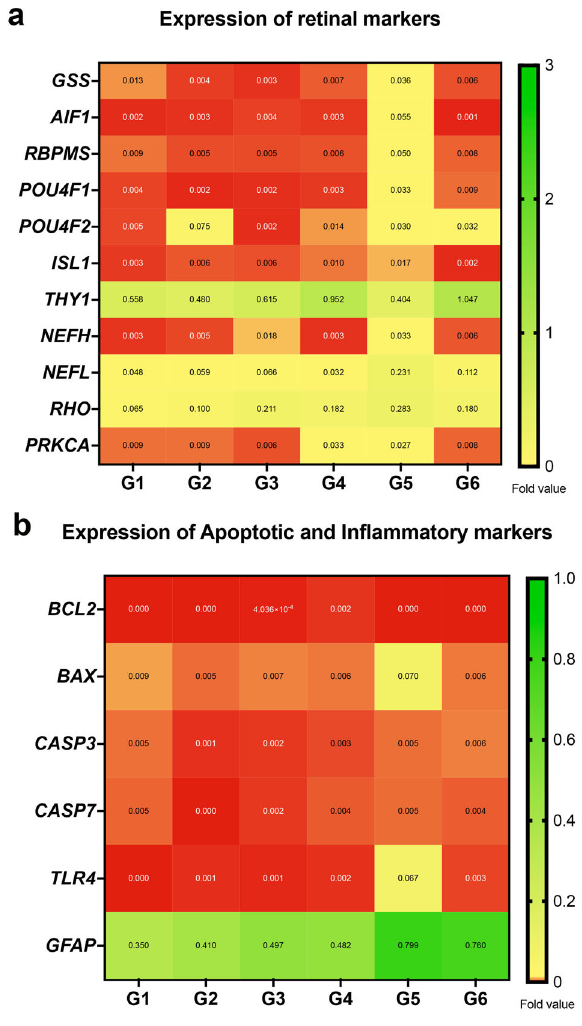
Fig. 3 Expression of retinal markers with increase in apoptosis and in fl ammation in experimental groups post culture. Heatmap of ( a ) retinal markers and ( b ) apoptotic and in fl ammatory markers in control and experimental groups ( N = 3). Mean fold values are indicated for each marker. G1 group 1, G2 group 2, G3 group 3, G4 group 4, G5 group 5, G6 group 6.